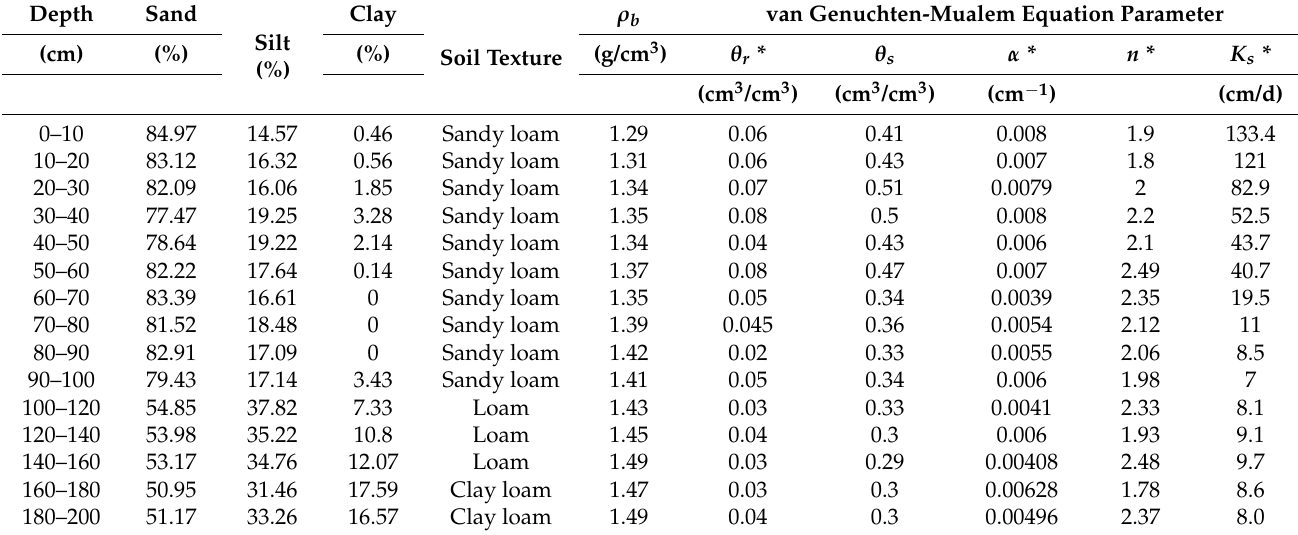
Table 2. The mechanical soil composition and calibrated hydraulic parameters used in the simulation of the different soil